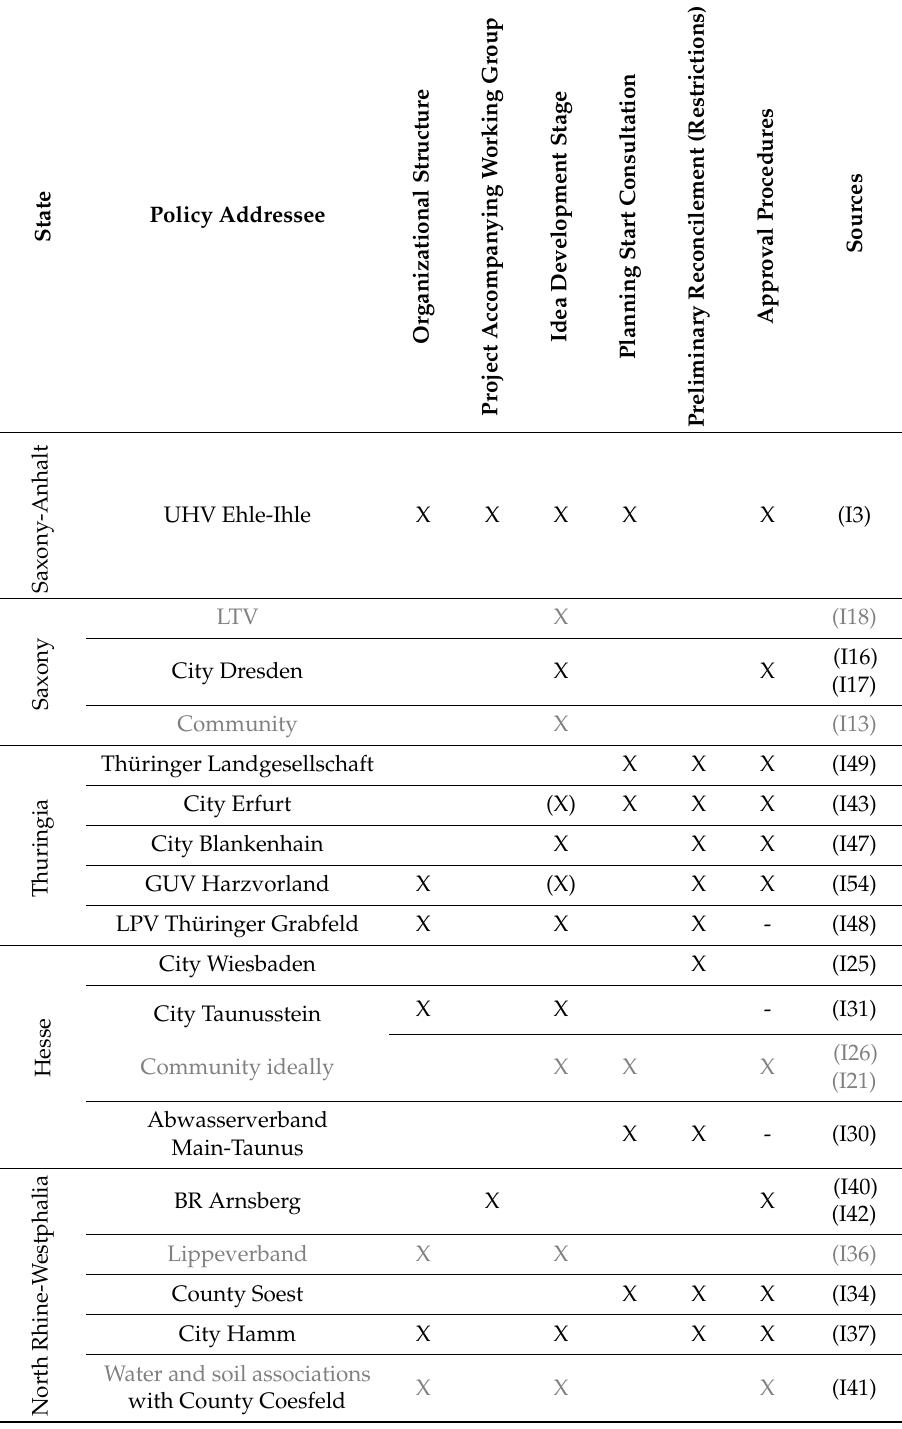
Table 2. Integration attempts of local policy addressees according to planning